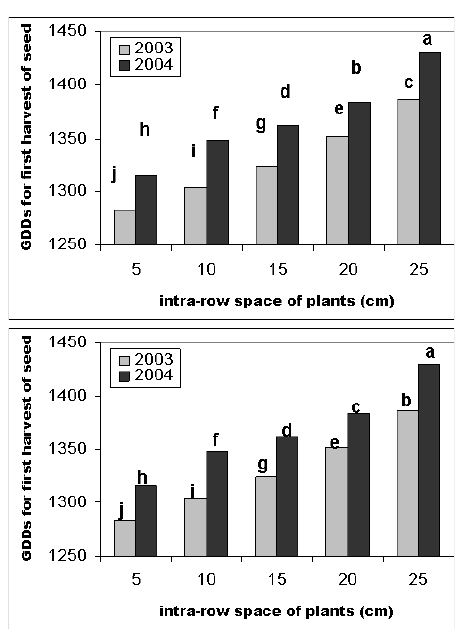
Fig. 2. Means of interaction between year and plant density on GDDs of first harvest of flower and seed. The same letters show non-significant differences Tab. 5. Means of interaction between irrigation regimes and plant density on the maximum numbers of sub stem per plant Intra-row space of